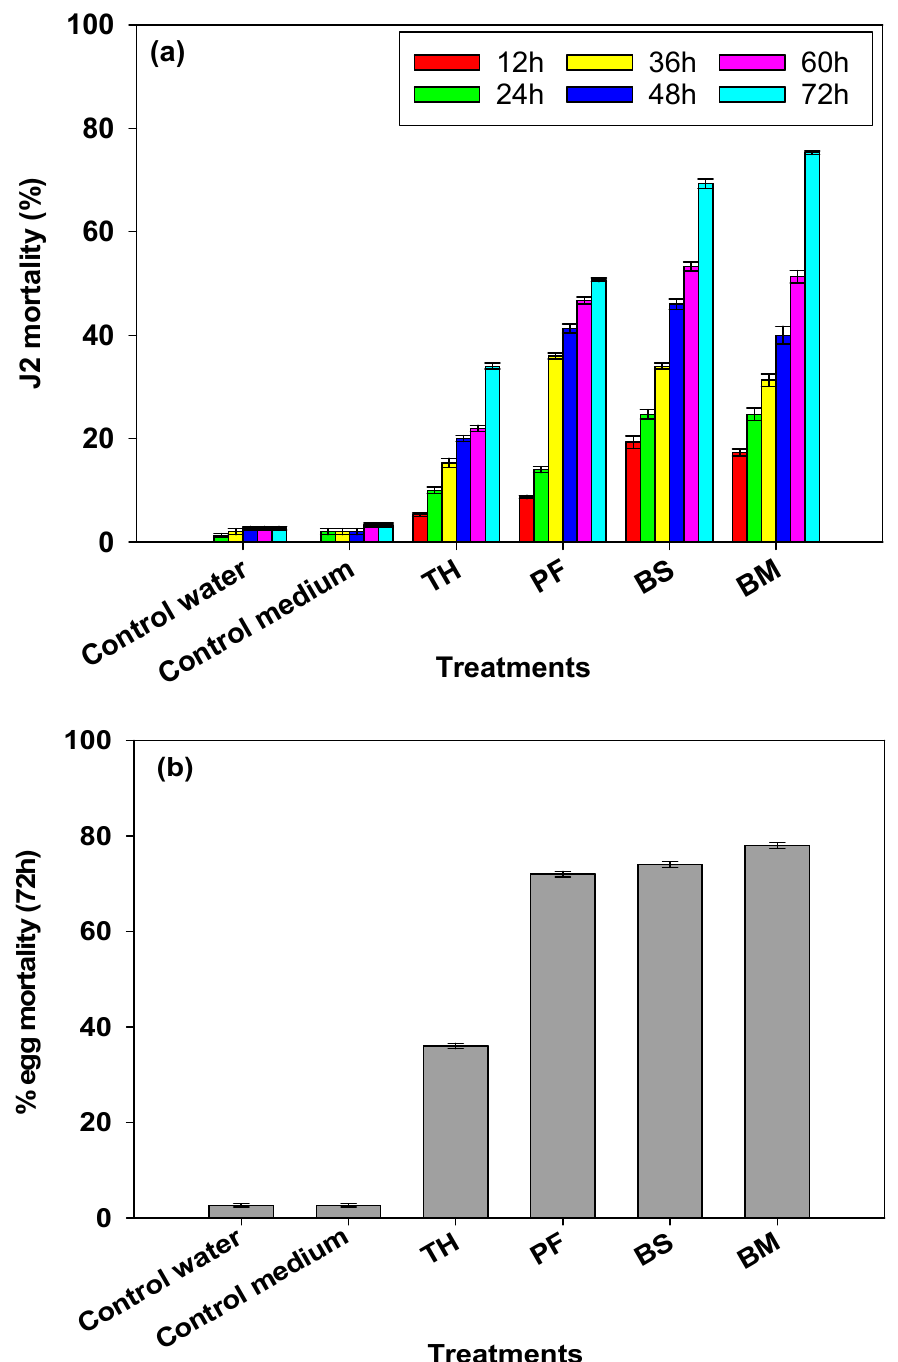
Figure 3. ( a ) Impact of cell free culture filtrates of Trichoderma harzanium (TH), Pseudomonas fluorescens (PF) Bacillus subtlis (BS) and B. megaterium (BM) on larvae (J2 stage) mortality of Mi (in %) at different time intervals. ( b ) Impact of cell free culture filtrates of. TH, PF, BS and BM on egg mortality of Mi at 72 h (in %). Distilled water and the medium used for bacterial culture were used as controls. The vertical bar represents mean of three replicates and standard error of mean (SE).